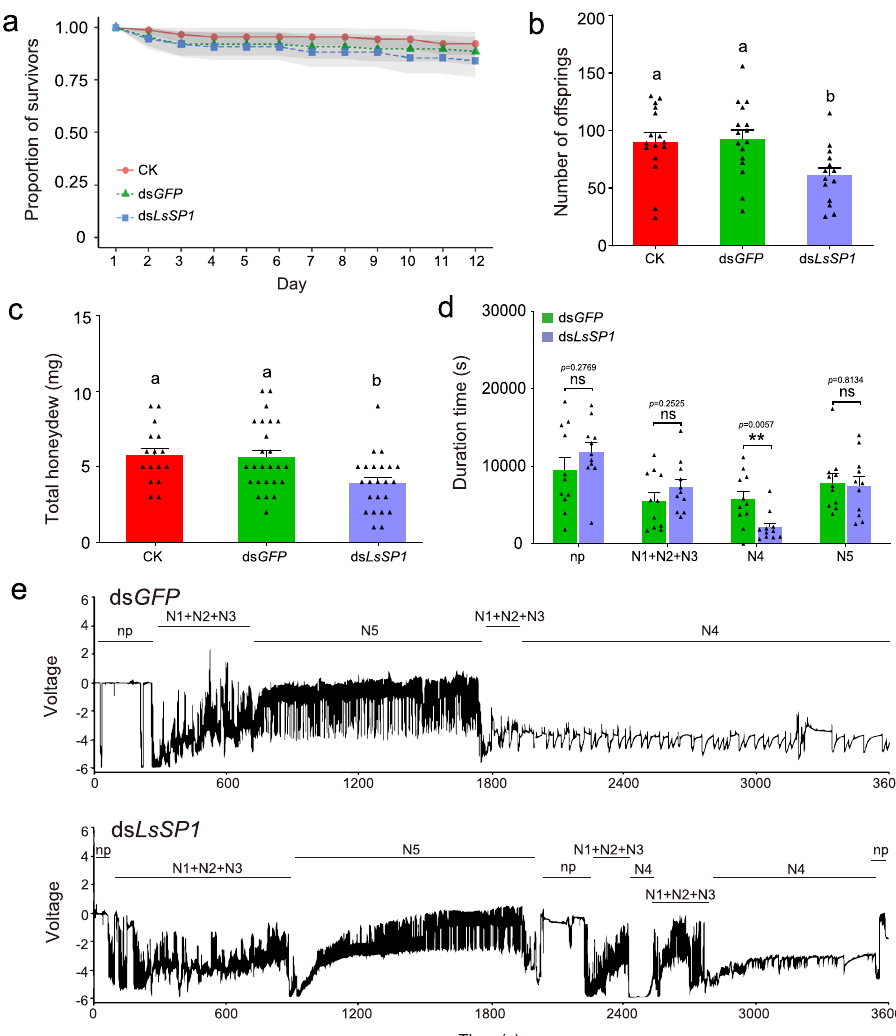
Fig. 1 | Effect of dsRNA treatment on Laodelphax striatellus . a – c Effect of LsSP1 knockdownon L.striatellus survivalrate( a ),fecundity( b ),andhoneydewexcretion ( c ).The untreated (CK) and ds GFP -treated L. striatellus wereusedascontrols. Data in a are presented as mean values ±95% con fi dence intervals (displayed in light shades). Different lowercase letters indicate statistically signi fi cant differences at P <0.05 level according to log-rank test ( a ) or one-way ANOVA test followed by Tukey ’ s multiple comparisons test ( b , c ). d Comparison of electrical penetration graph (EPG) parameters between ds GFP -treated and ds LsSP1 -treated L. striatellus . AllEPGrecordingswereperformedfor8h. P -valuesweredeterminedbytwo-tailed unpairedStudent ’ s t test.** P <0.01;ns,notsigni fi cant.Datain b – d